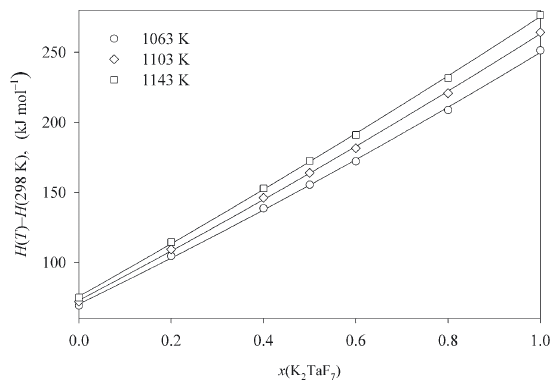
Figure 1. Composition dependences of the relative enthalpy of melt in the system KF–K 1, 2 and 3.